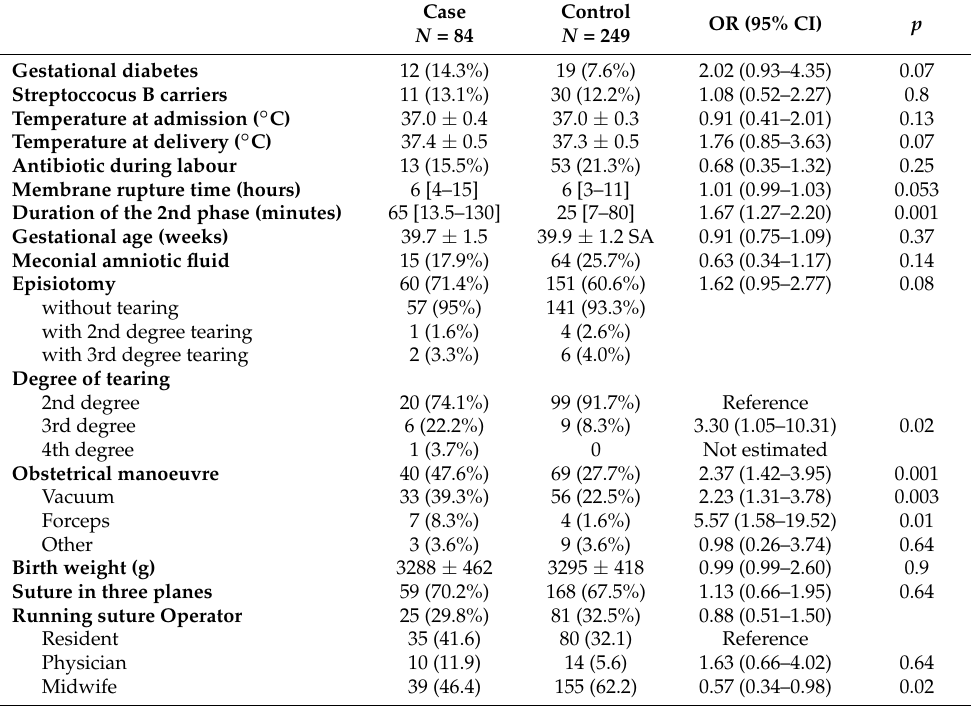
Table 2. Intrapartum